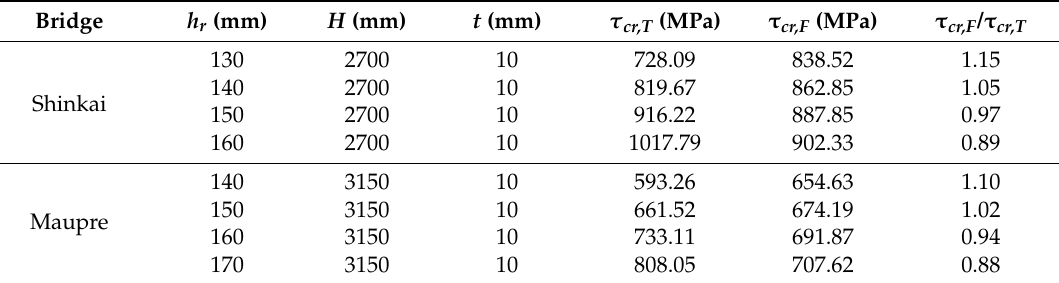
Figure 12. Global elastic shear buckling strength of PCCSW in theory τ cr,T versus different angles θ 1 , θ and θ 2 ( R = 110 m). Table 5. Global elastic shear buckling strength of PCCSW with varying corrugation height for R = 110